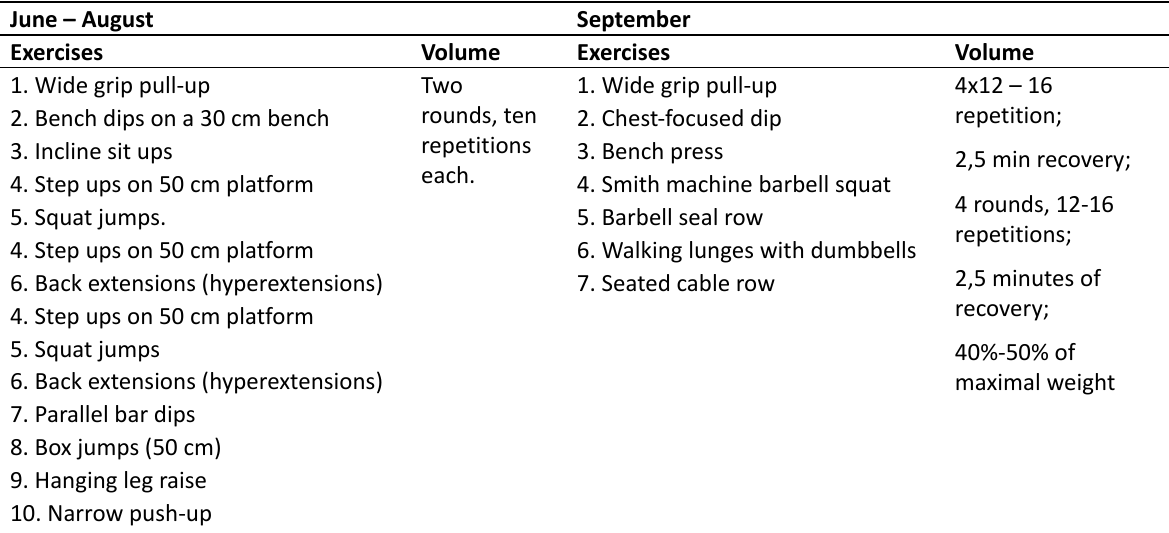
Table 1. Additional training protocol for cross-country skiing